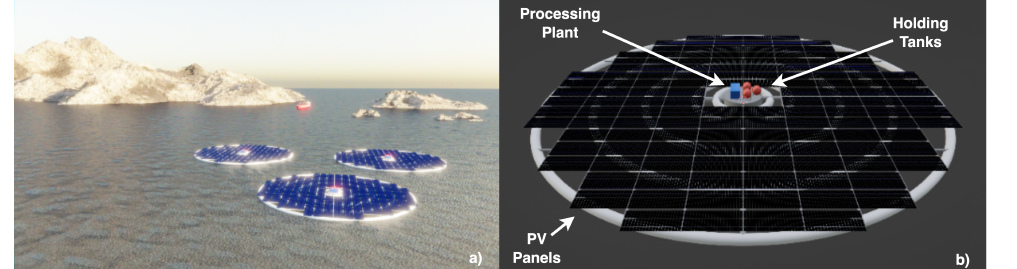
Figure 1. Artistic rendering of solar methanol island. ( a ) shows the device in a potential deployment scheme, serviced by a tanker ship. ( b ) shows a close-up of the device with its different main components: the floating structure and solar panels, the processing plant, and the holding tanks for the produced methanol. Further detail of the device’s processes are given in Section